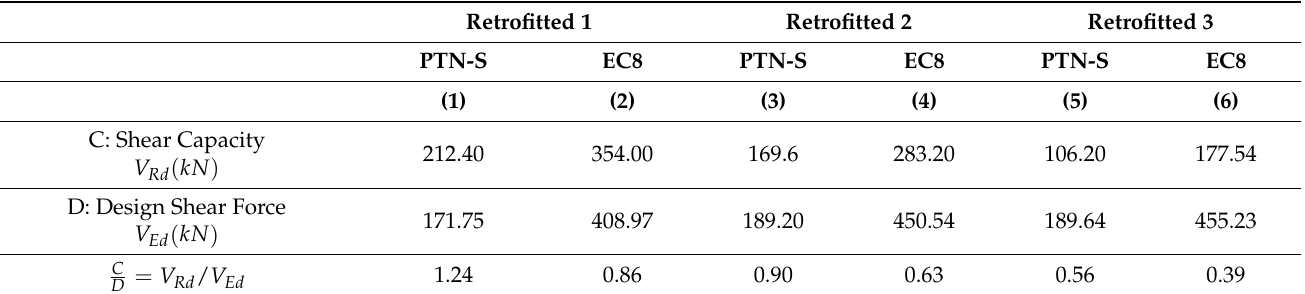
Table 9. Comparison of the seismic capacity (C) and demand (D) for the analyzed wall at the ground floor level (for the retrofitted structure).